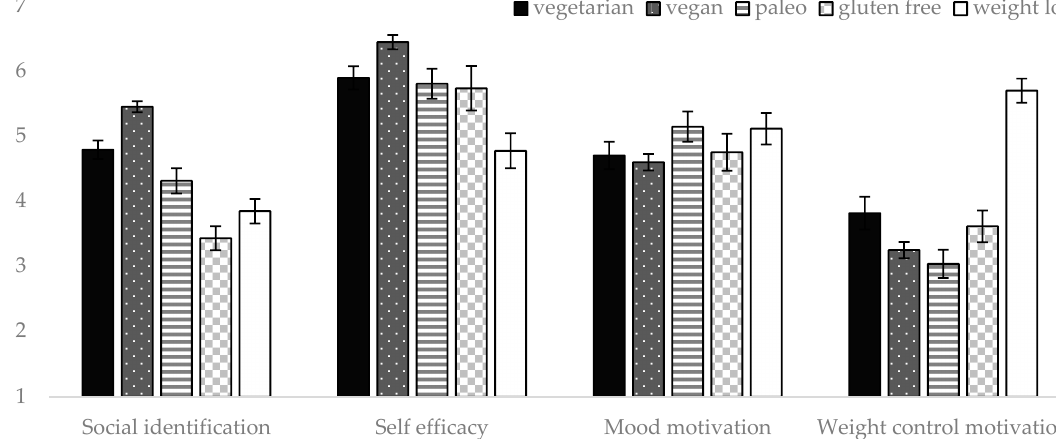
Figure 2. Differences in the average level of endorsement of each correlate of measured and/or subjective adherence between dietary groups. Note. Error bars represent standard errors. Self-efficacy has been converted to a seven-point scale for graphing purposes, but was a ten-point scale in the analyses.